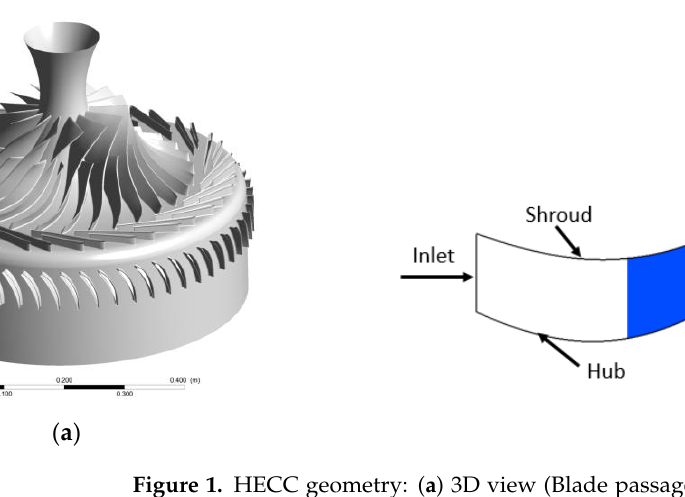
Figure 1. HECC geometry: ( a ) 3D view (Blade passages are duplicated for better figure quality); ( b ) Meridional section and component of the HECC.